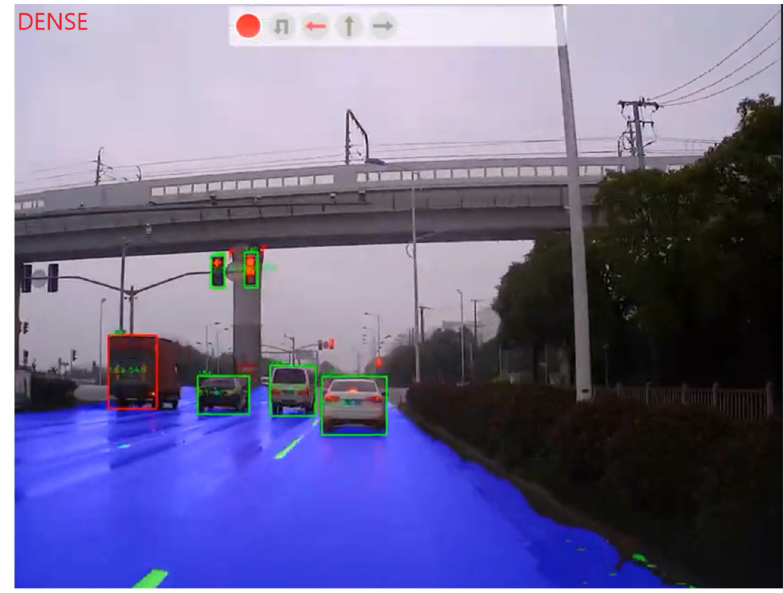
Figure 13. RTDE example output 2—DENSE scenario.